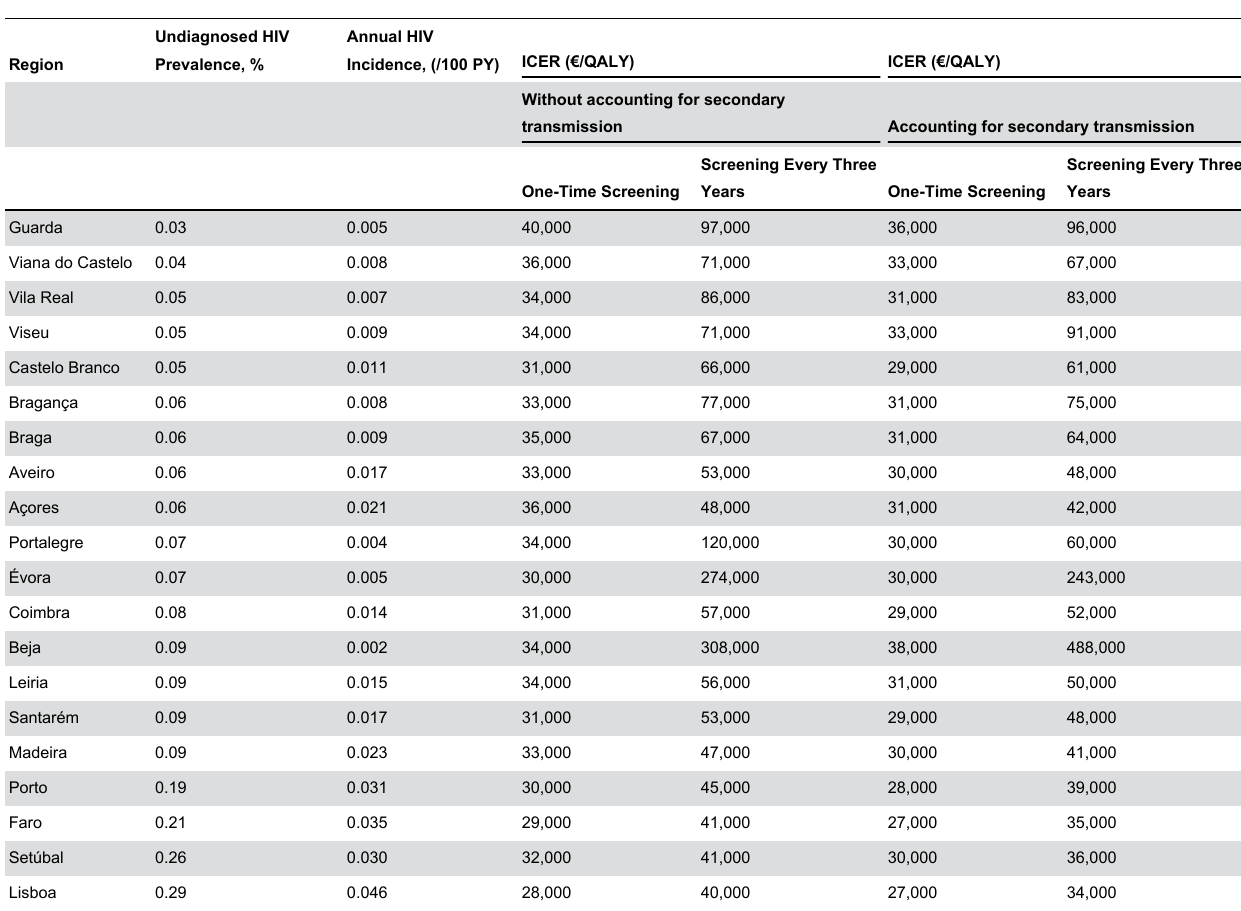
Table 3. Results: Regional Analysis of Routine HIV Screening in Portugal.